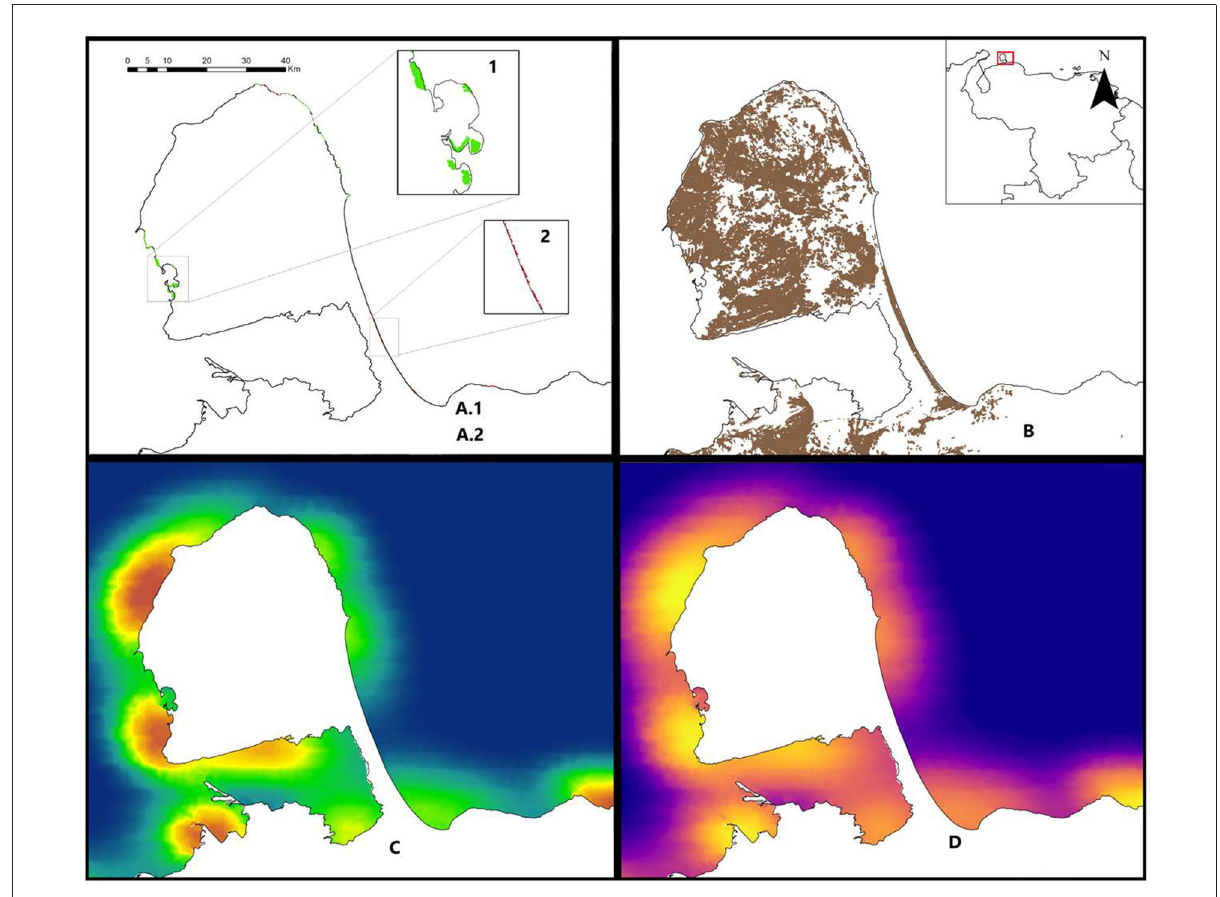
FIGURE5 Layers of ecosystems for the model of cumulative impacts and aquatic stressors on the central coast of Falcón state, Venezuela. (A) 1) Seagrass 2) Rocky shoreline (B) Bush (C) Nutrients (D) Chemical pollution.